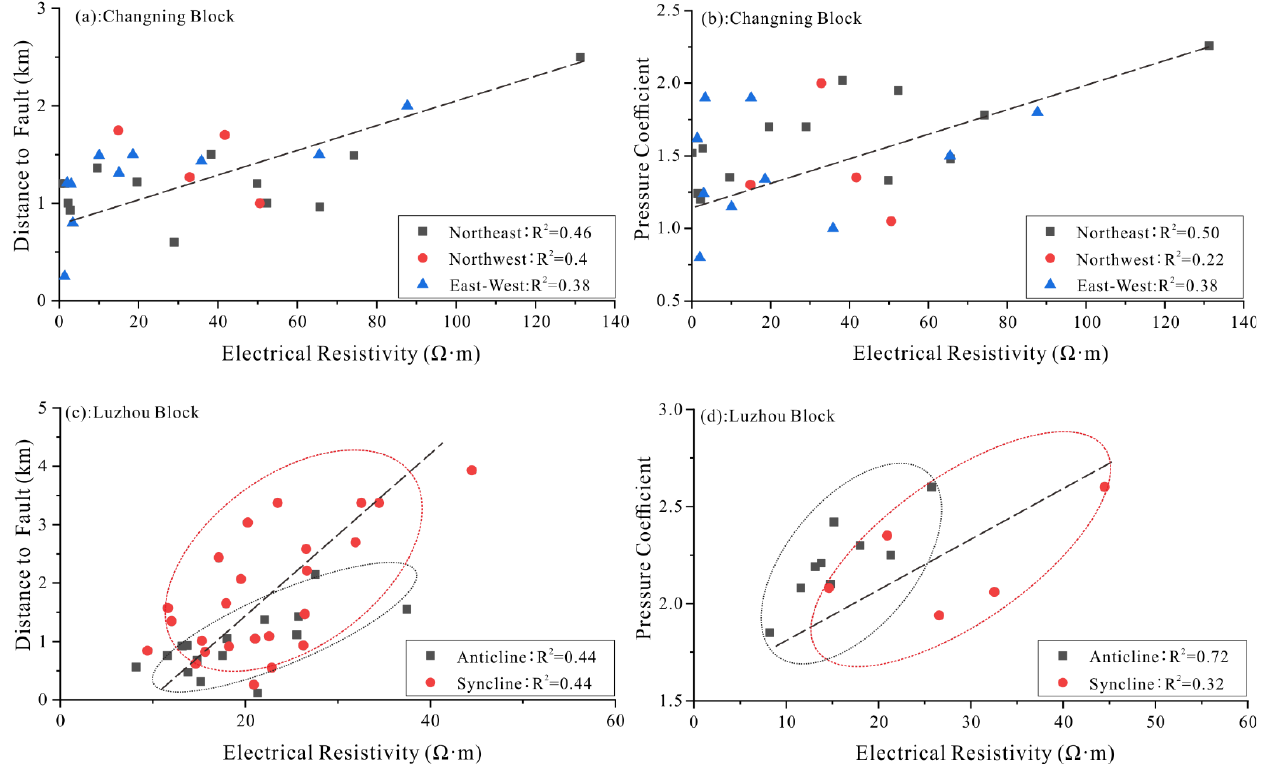
Figure 9. Plots of structural factors controlling electrical resistivities of shales in the Southern Sichuan Basin, ( a ) correlation between distance to fault and electrical resistivity at the Changning block, ( b ) relationship between pressure coefficient and electrical resistivity at the Changning block, ( c ) correlation between distance to fault and electrical resistivity at the Luzhou block, ( d ) relationship between pressure coefficient and electrical resistivity at the Luzhou block.